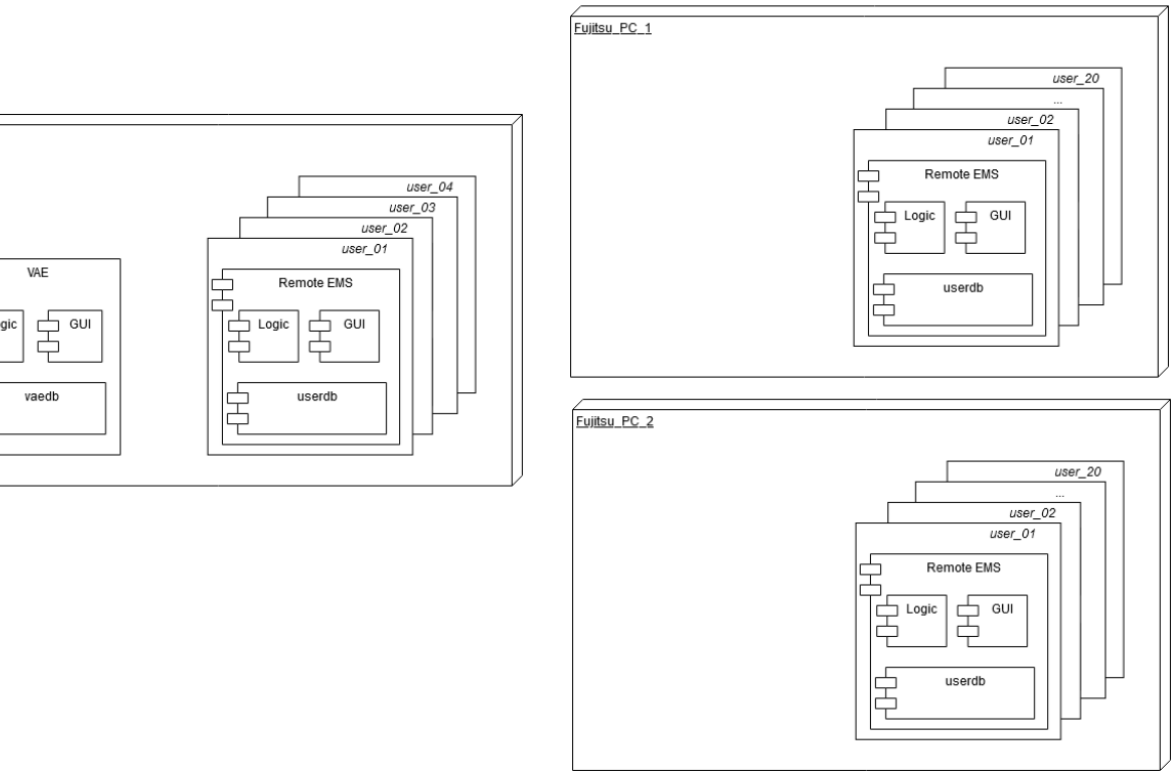
Figure 15. Deployment diagram of the test environment.